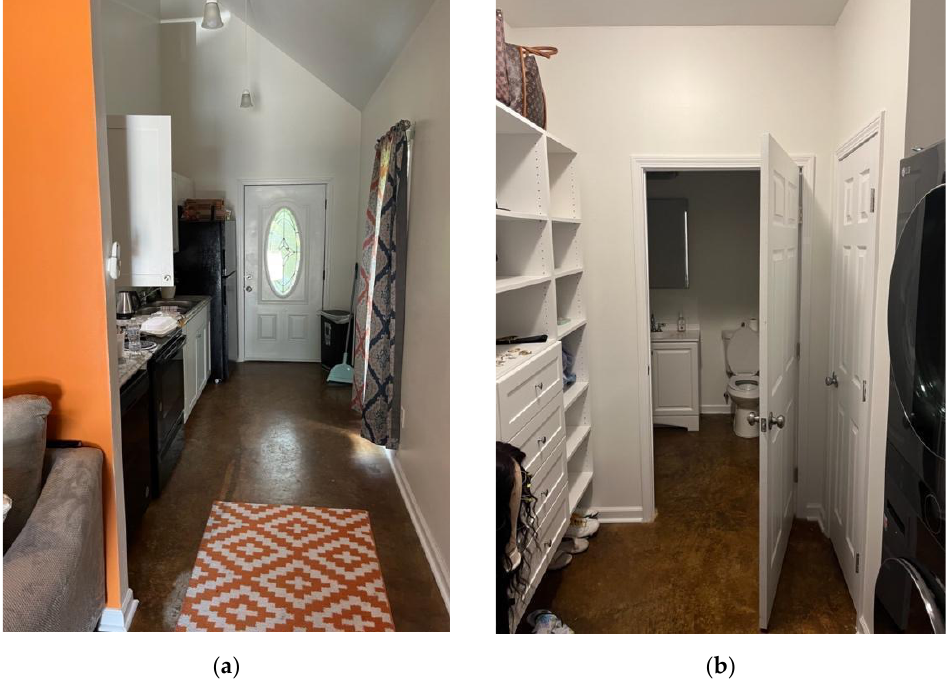
Figure 4. ( a ) Inside the newly constructed tiny homes, the kitchen is attached to the main living space and has access to the back porch. The kitchen was fully stocked and in use during our visits, highlighting the home’s association with domesticity. ( b ) A door separates the closet and laundry room from the main living space. This room leads to a large bathroom. The tiny homes are located in deep, narrow lots in a neighborhood populated by single-family homes and duplexes. Each lot includes a driveway (though not typically a covered garage) and a backyard. We observed few fences or gates as we walked in the neighborhood. Barely any property markers exist between lots, and the distance between neighboring houses is seldomly longer than the size of a one-car uncovered parking space. The “welcome” sign and two stools by the side of the tiny home’s front door depicted in Figure 1 communicate its occupant’s openness to interacting with her neighbors. The house “fits in” the residential street not least because of the lack of defensive design. There are no fences, railing, shutters to protect the windows, or surveillance cameras. When asked about the lack of window protectors, one resident remarked that she had installed